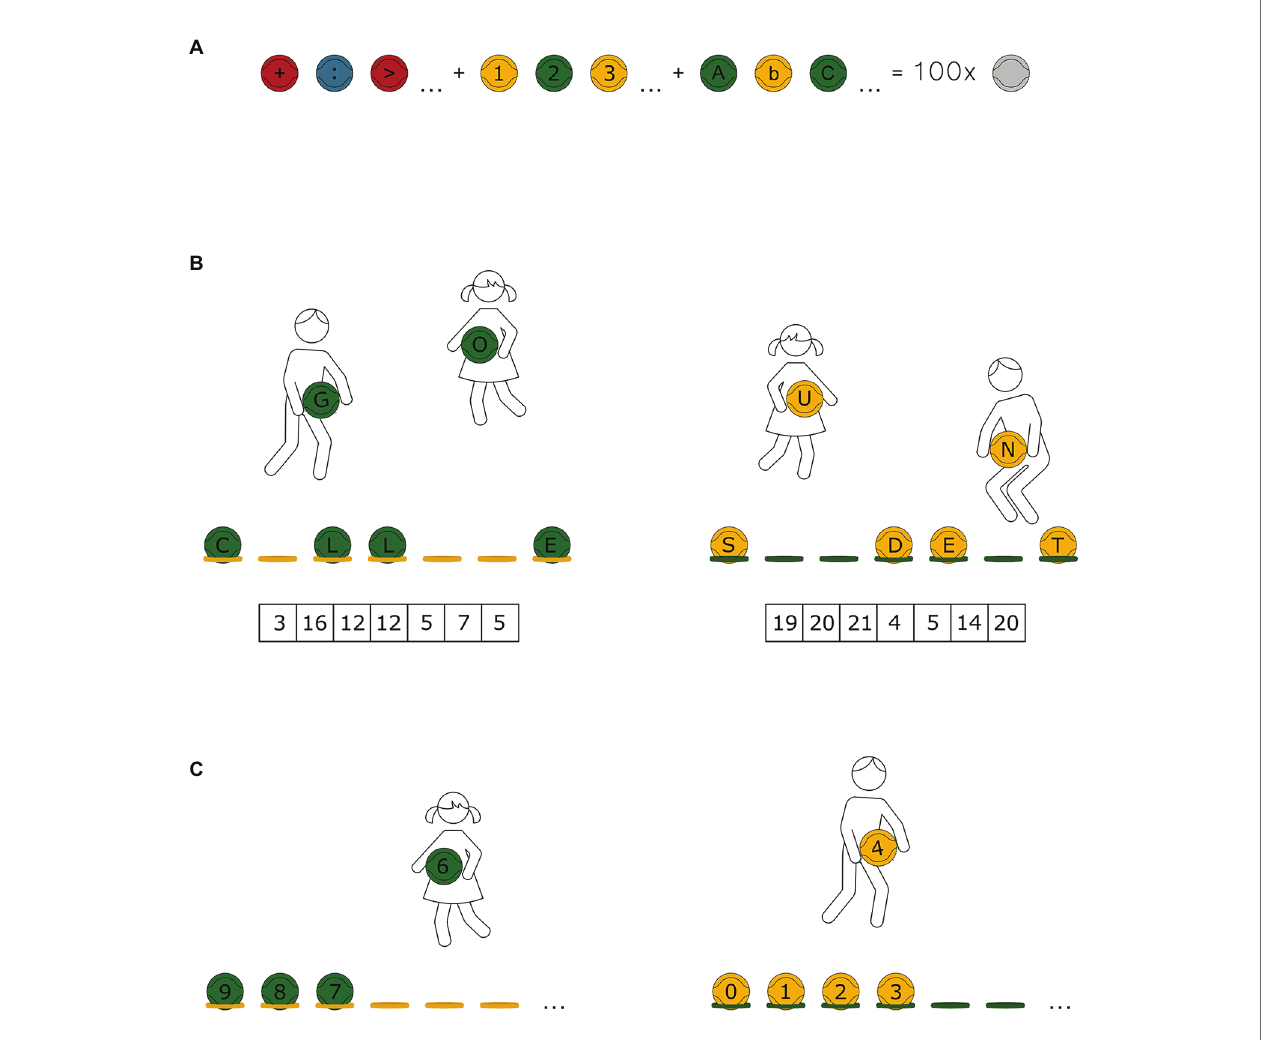
FIGURE 1 | Eduball educational balls. (A) A set of Eduballs includes 100 balls used for team mini-games in five colors (blue, green, orange, red, and yellow) with painted (black) letters of the alphabet (upper and lower case), numbers from 1 to 9 and 0, symbols of mathematical operations, such as addition (+), subtraction ( − ), multiplication (*), division (:), greater than (>), and smaller than (<). (B) Example of math Eduball-game: “From 0 to 9.” The students, divided into two teams (yellow and green), freely move across the whole gym. At the educator’s signal, the pupils with the yellow balls need to line up as fast as they can from smallest to biggest number. The green team has to line up from largest to smallest number. (C) Example of language Eduball-game: “Enigma.” The learners, divided into two teams (yellow and green), obtain coded messages (numbers represent the order of letters in the alphabet). The pupil’s task is to decode the message and arrange the word from the letters on the